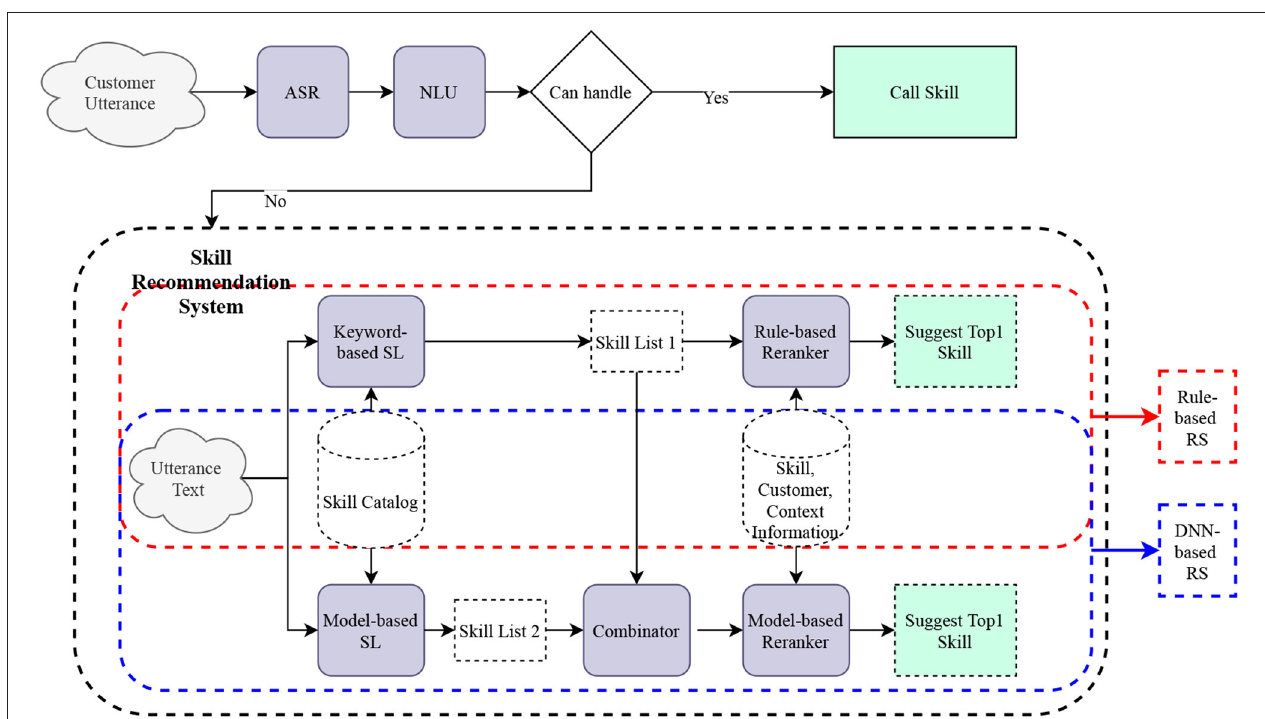
FIGURE 1 | An overview of two stage skill recommender